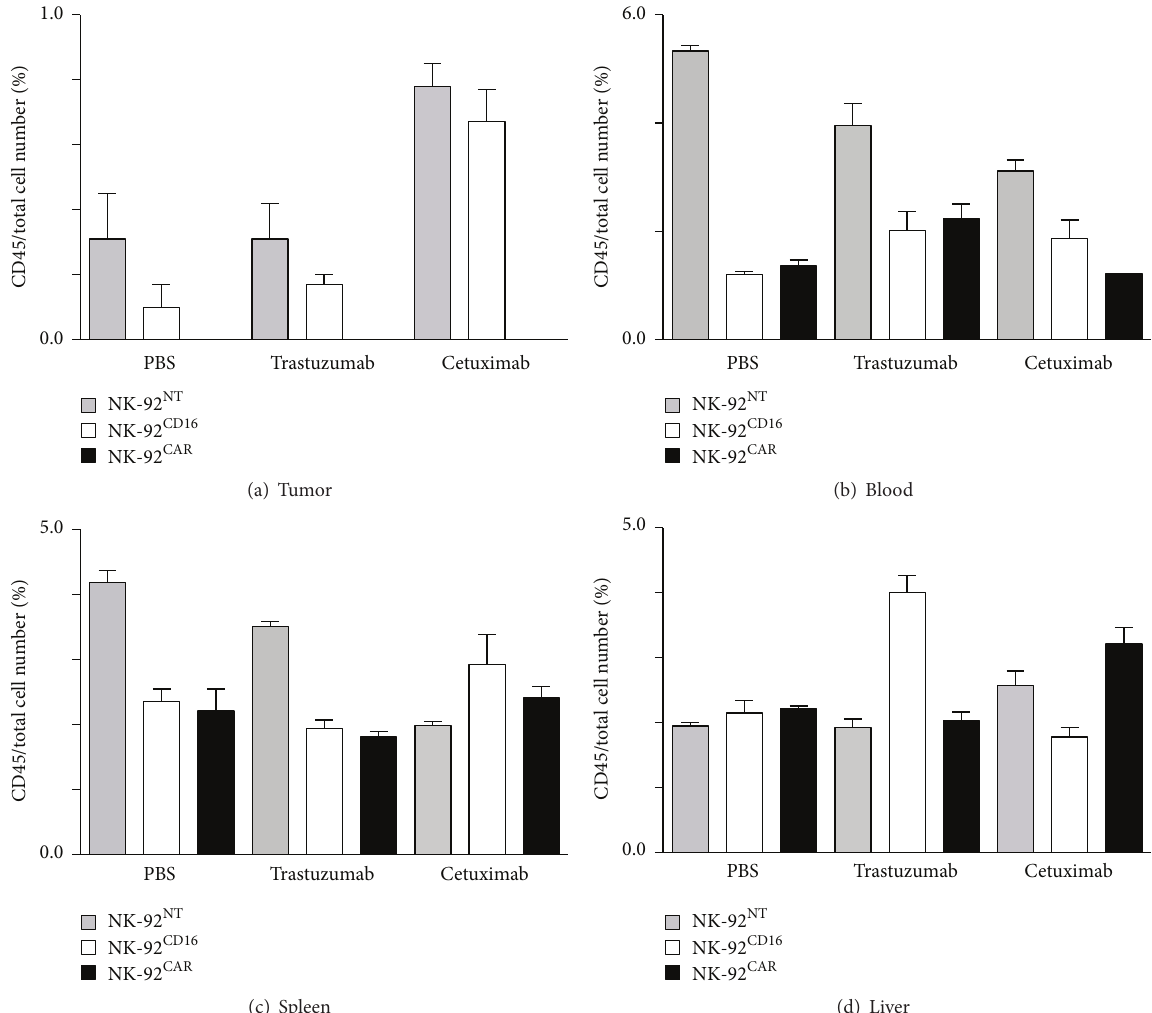
Figure 5: Tissue distribution of NK- 92 NT , NK- 92 CD 16 , and NK- 92 CAR in NSG mice bearing an established BT474 tumor. NK- 92 NT , NK- 92 CAR , or NK- 92 CD 16 CSFE labelled cells ( 20 × 10 6 ) were injected into NSG mice bearing BT474 tumors (tumor size range of 50 to 100 mm 3 ). Twenty-four hours later, mouse blood, liver, tumor, lung, and spleen were collected, and the percentages of CD45 positive cells were analyzed by FACS analysis (percentage of CD45 was calculated from 50,000 events, and the means of two independent experiments are